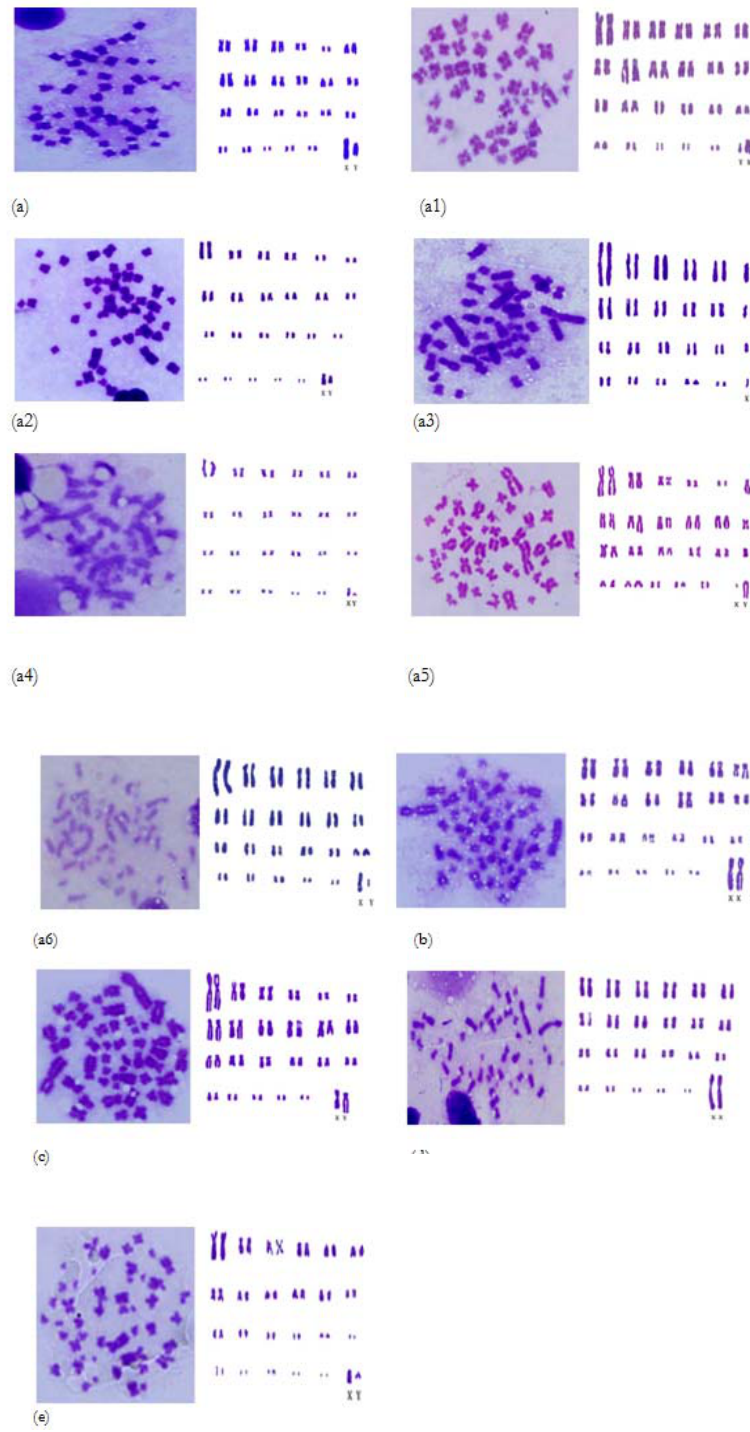
F IGURE 2. Metaphase spreads and idiograms of the genus Allactaga . (a) A. elater from Aq Qala (a1) Sarakhs (a2) Kavir, Yazd (a3) Tabas (a4) Gonbad (a5) Incheborun (a6) Kashmar (b) A. euphratica (c) A. williamsi (d) A. hotsoni (e) A.